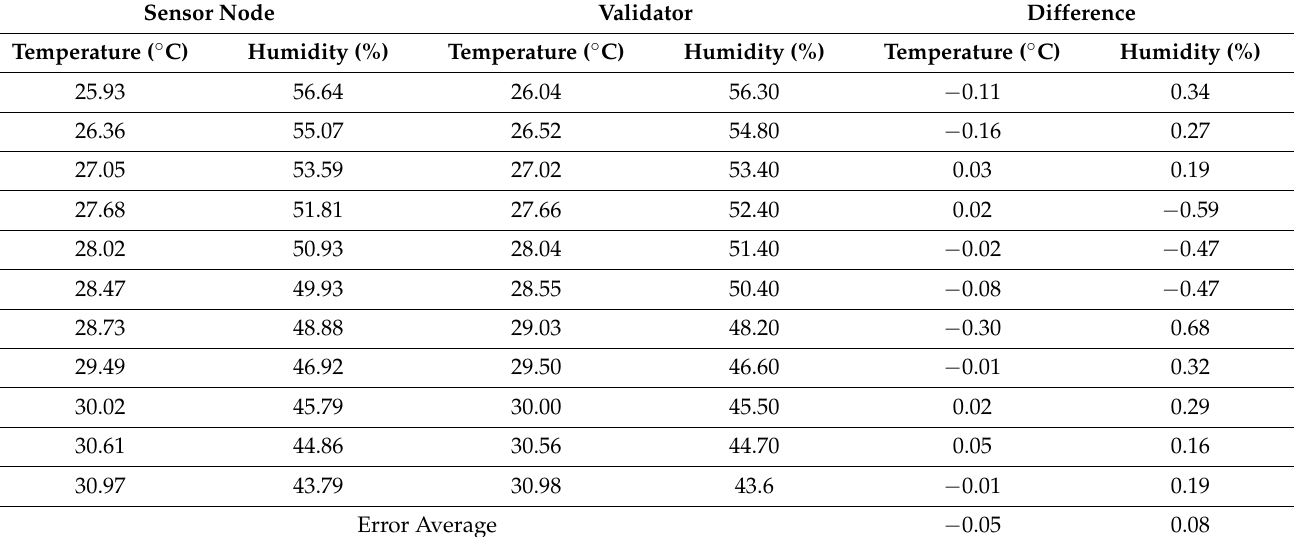
Table 11. Temperature and humidity results after calibration.